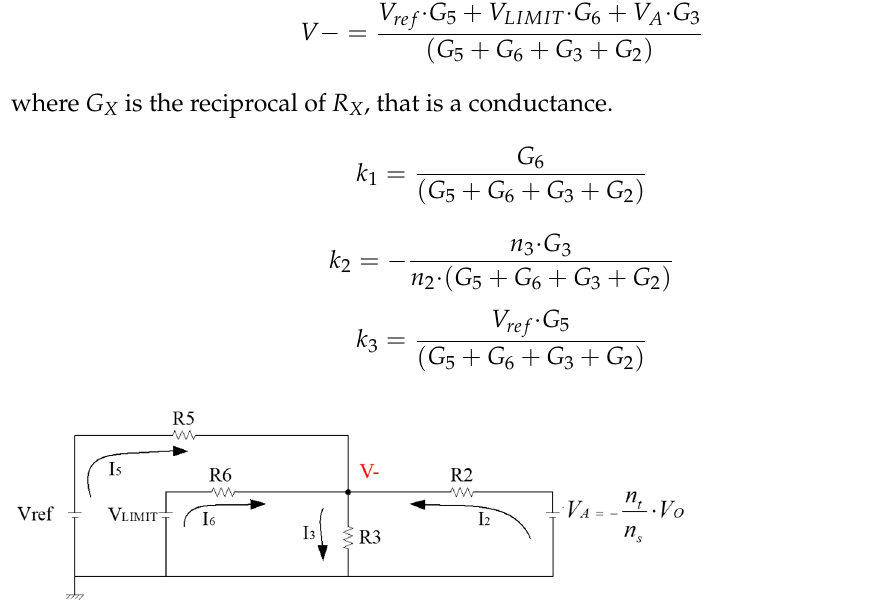
Figure 8. Simplified FBC circuit.